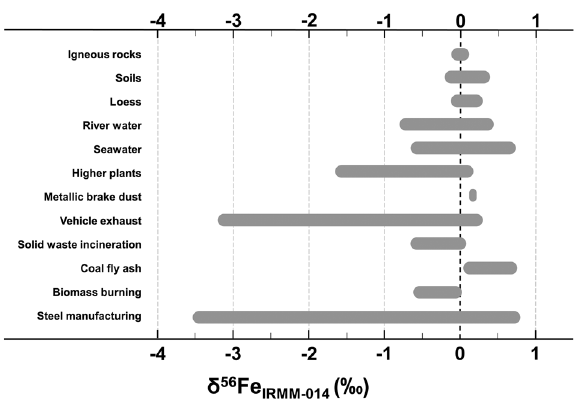
Fig. 1 Iron isotopic variations ( δ 56 Fe, by reference to the IRMM- 014 standard, shown as shadow bar) of natural and anthropo- genic (pyrogenic) aerosol sources. Natural sources include igneous rocks 125 , soils 148,162 , loess 163,164 , river water 114,124 , sea water 52,134,165 , and higher plants 138 . Anthropogenic (pyrogenic) sources include metallic brake dust 143 , vehicle exhaust 141 , solid waste